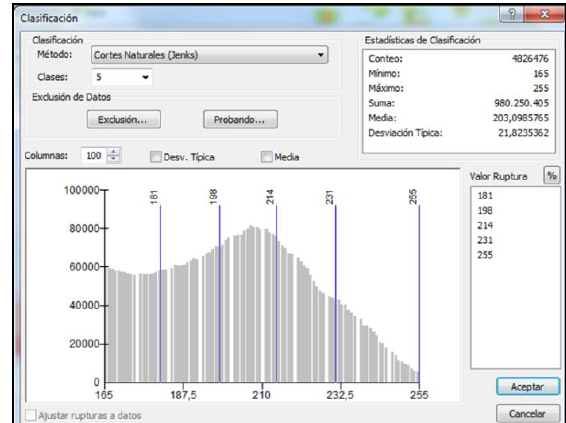
Light the “periurban landscapes”, as shown in Figure 5. The figure 6 represents the results of such methodology used in the case of Southern California.